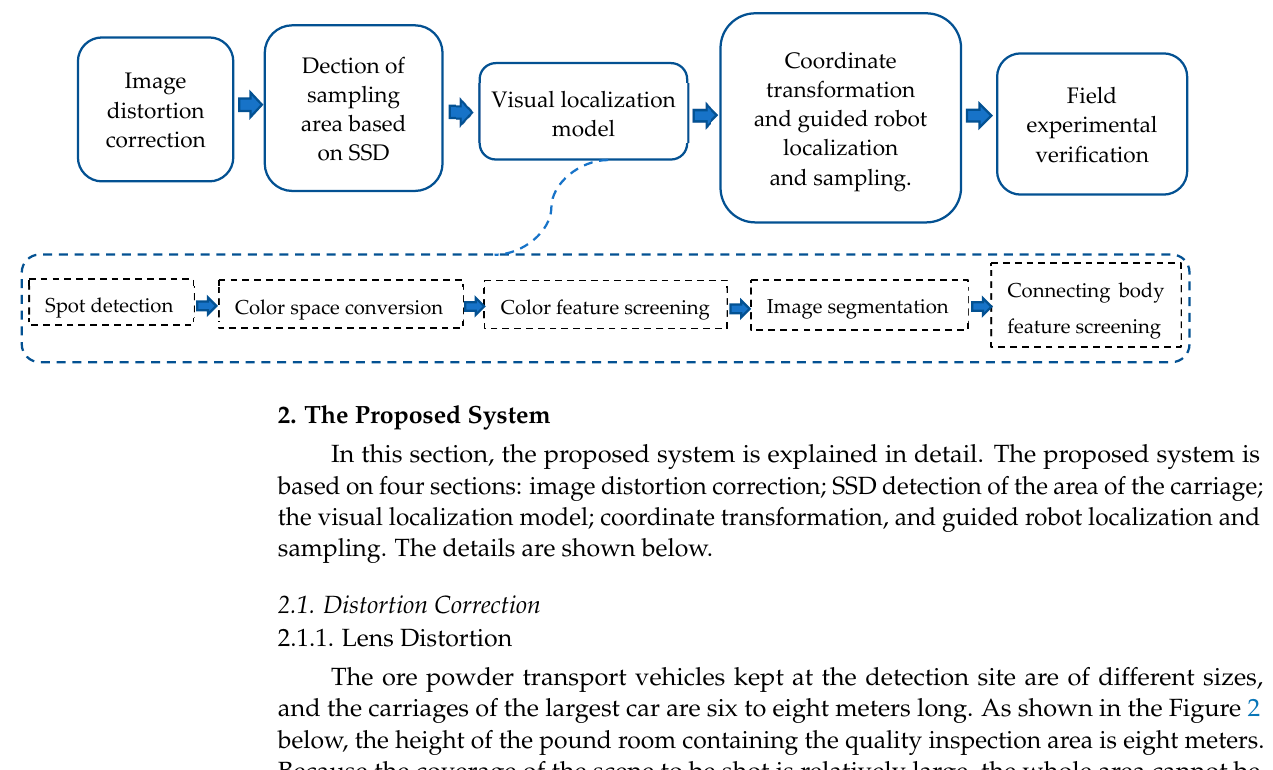
Figure 2. Wide-angle lens shooting.